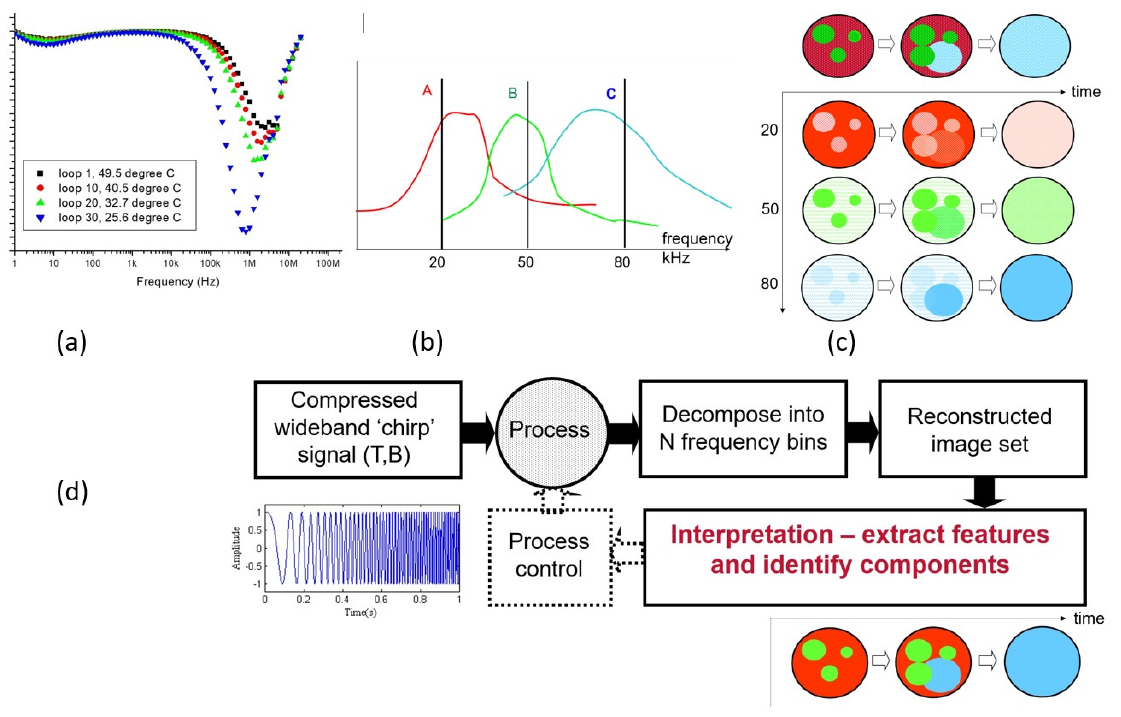
Figure 2. Principle of spectro-tomography ( a ) Example material spectral contrast characteristic. ( b ) simplified process contrast characteristic for reagents A, B and product C. ( c ) process state at 3 sample times. ( d ) composite excitation, reconstruction and interpretation